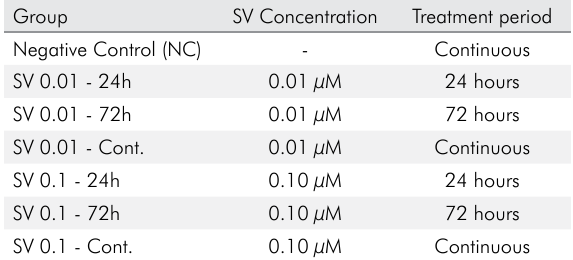
Table 1. Experimental groups according simvastatin (SV) concentration and treatment period Group SV Concentration Treatment period Negative Control